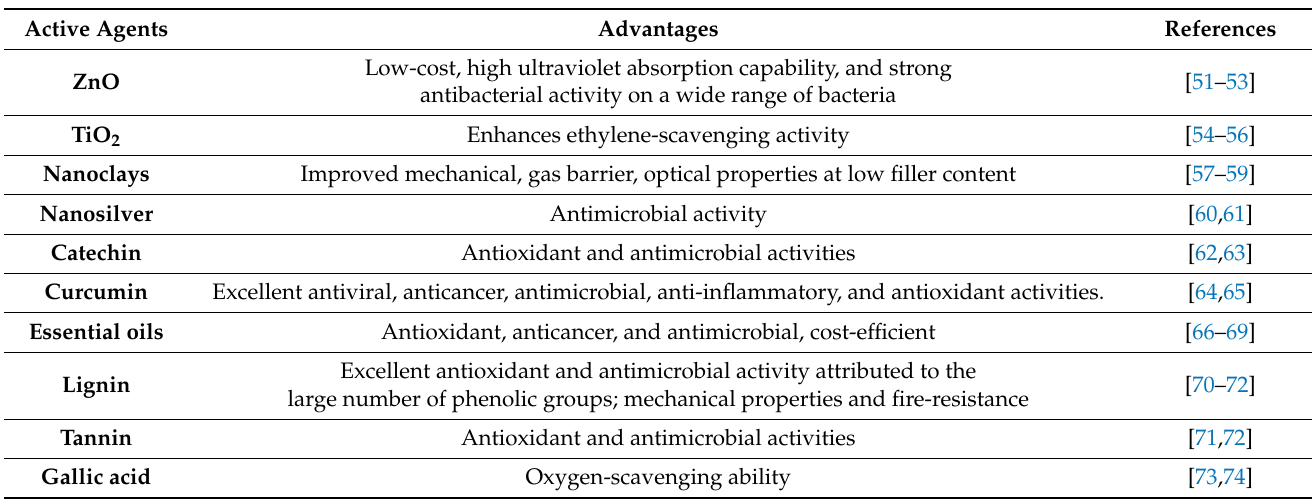
Table 1. Active Agents Widely Used for Bulk Preparation Methods. Active Agents